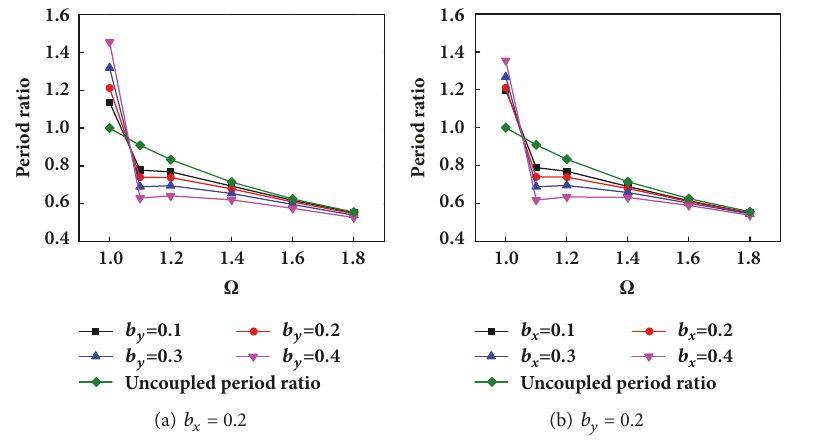
Figure 19: Variation of coupled period ratio and noncoupled period ratio with Ω